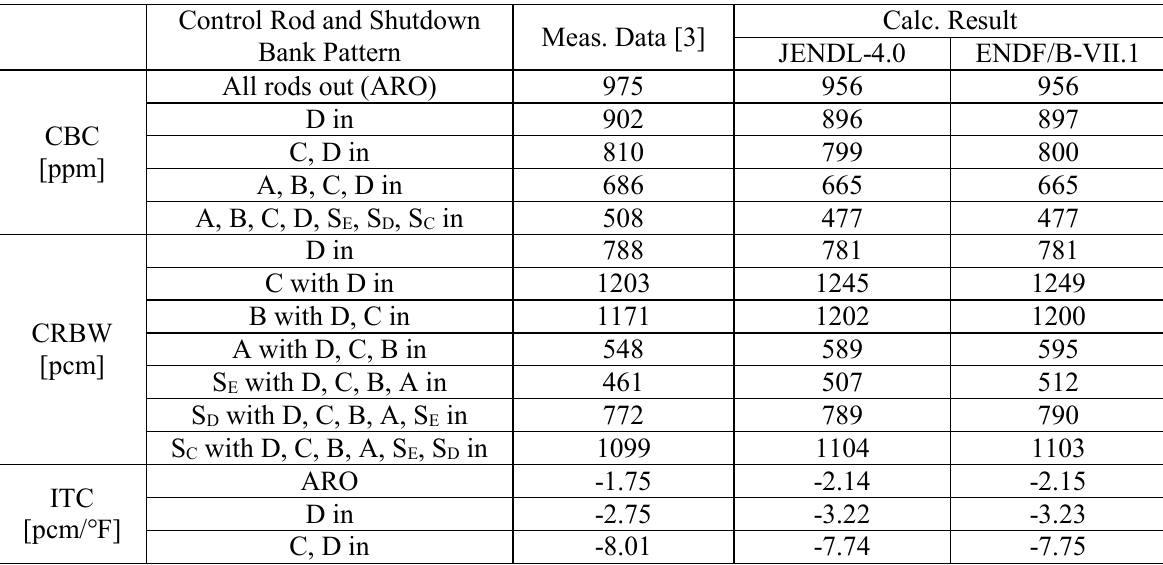
Table II. HZP Physics Test Results of Cycle